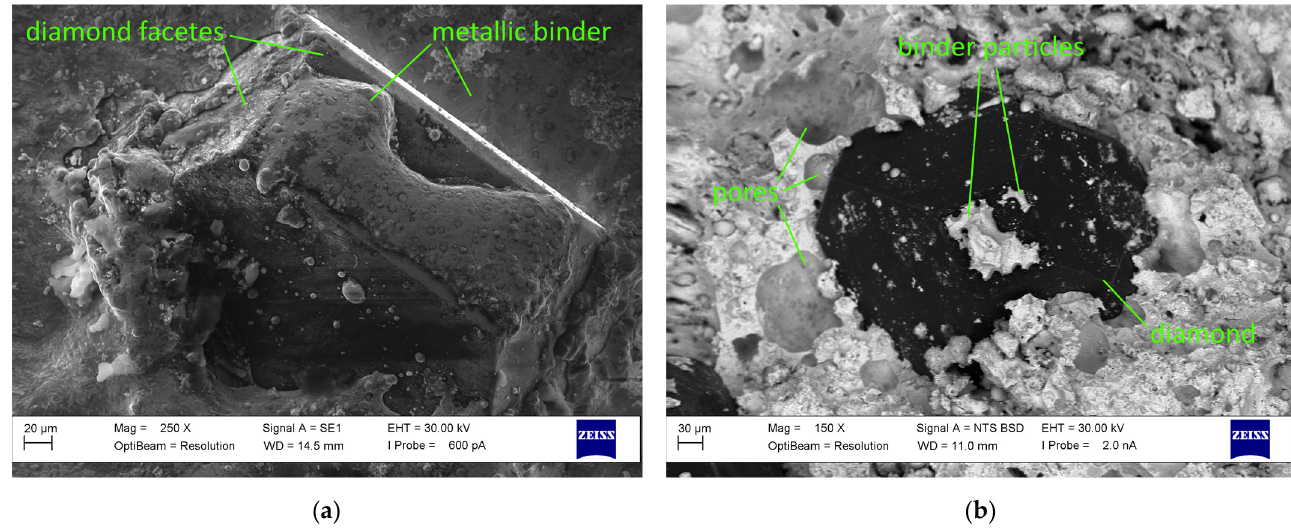
Figure 8. Diamonds on the surface ( a ) and in the fracture ( b ) of coating